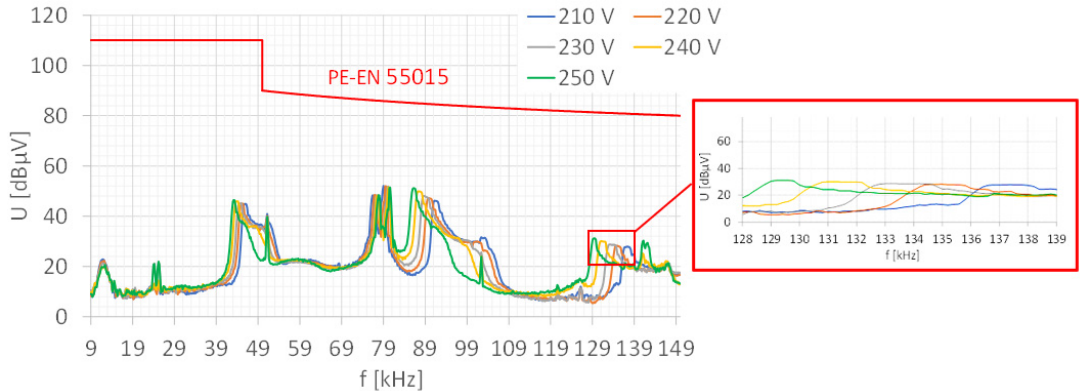
Figure 6. Supraharmonic spectrum and a close-up of the dominant emissions band of the set of lamps (CFL 20 W+LED 7 W) for various supply voltage values.